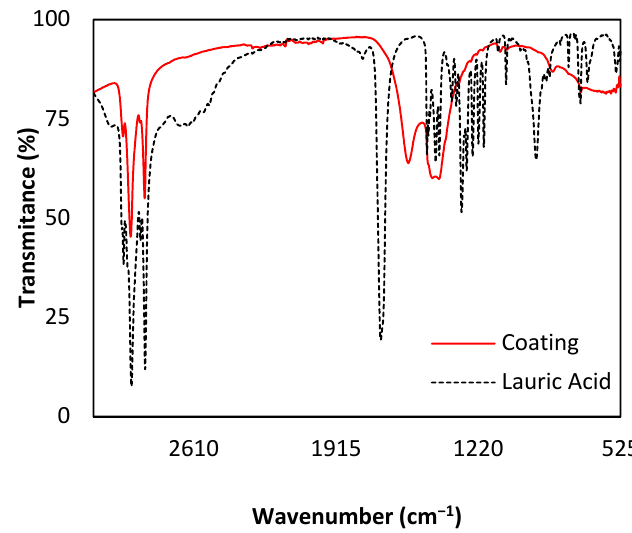
Figure 5. ATR-FTIR spectroscopy technique allows determining the formation of carboxylate compound after the electrodeposition process.